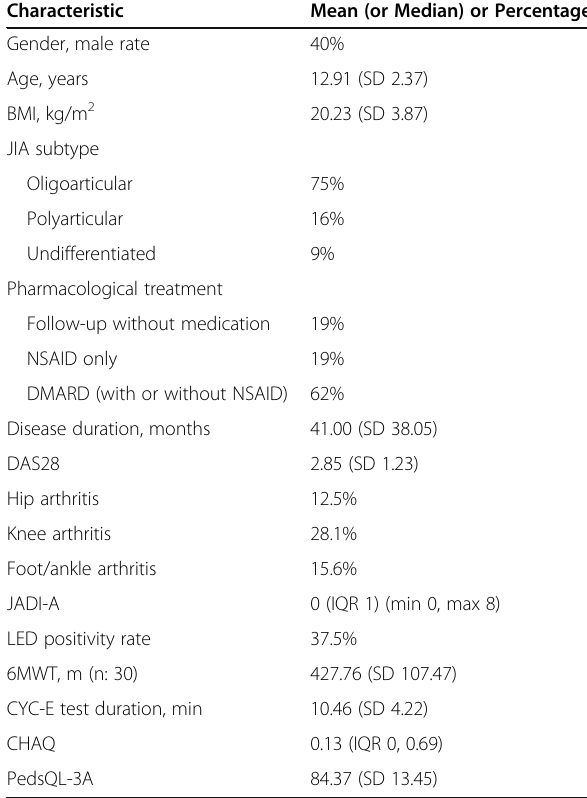
Table 1 Demographic and clinical characteristics of the patients